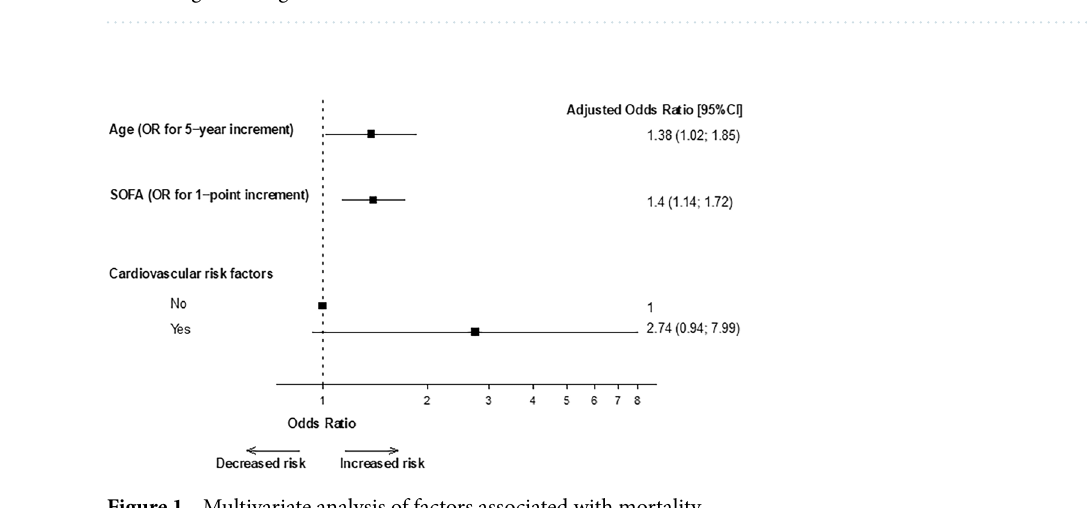
Table 3. Factors associated with mortality. SOFA sequential organ failure assessment. *Solid cancer and hematological malignancies.